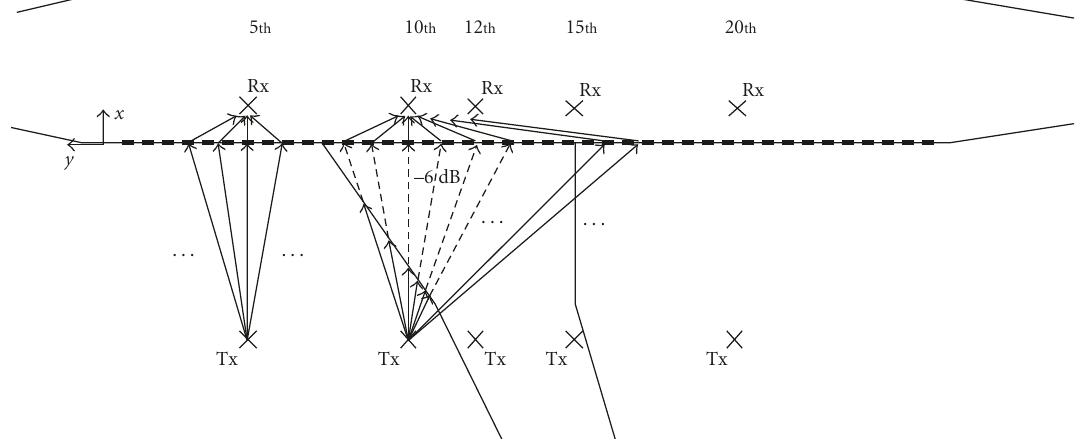
Figure 18: Received power level calculation